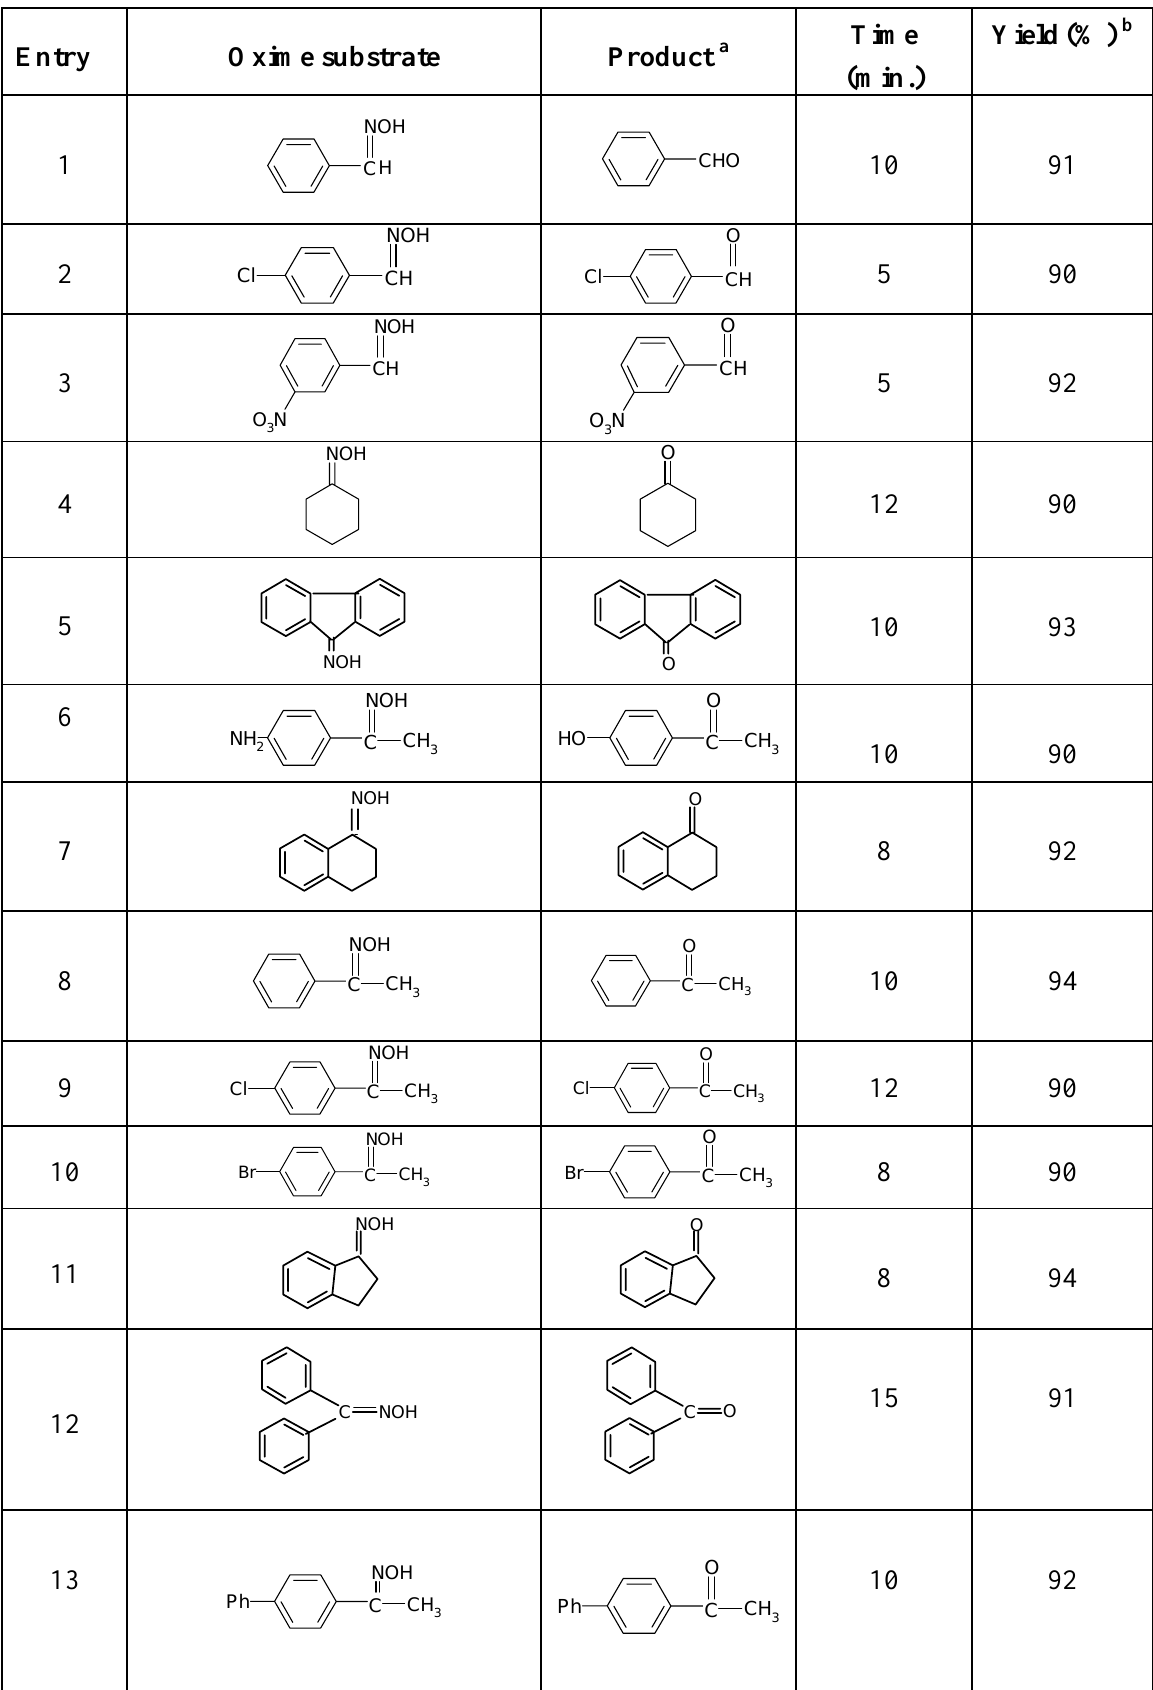
Table 1. Regeneration of carbonyl compounds from oximes using a heterogeneous